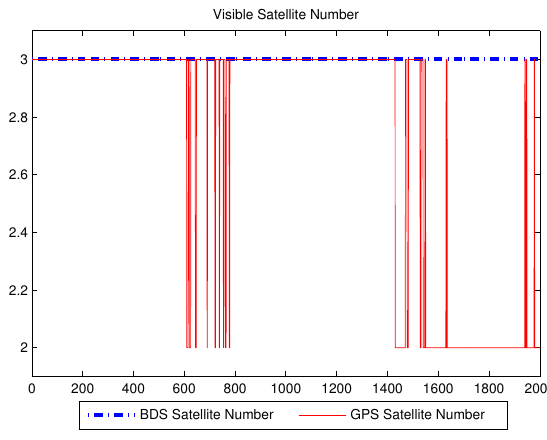
Figure 7. The number of visible satellites after